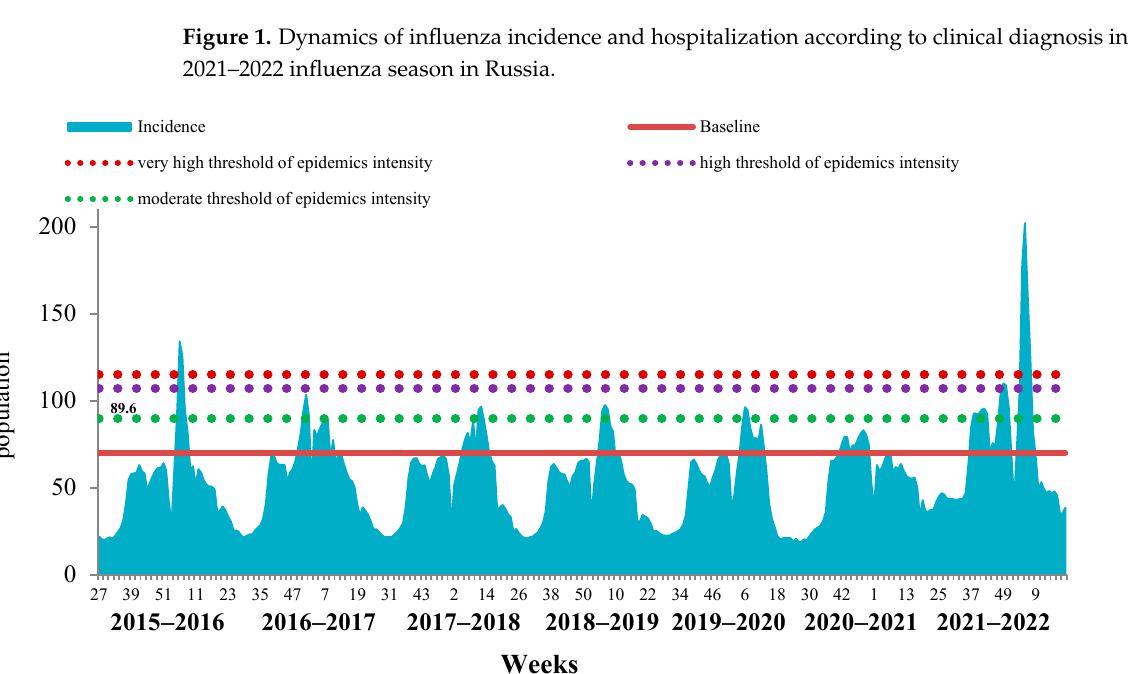
Figure 1. Dynamics of influenza incidence and hospitalization according to clinical diagnosis in the 2021–2022 influenza season in Russia.